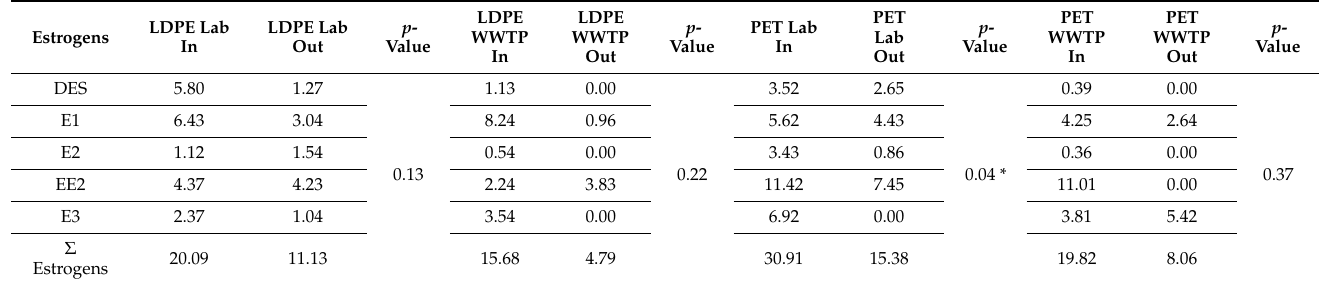
Table 1. Estrogens (ng g − 1 ) on the pellets (ng g − 1 ) (level of significance calculated using paired t -test between influent (in) and effluent (out); * p < 0.05 with two-tailed relevance).